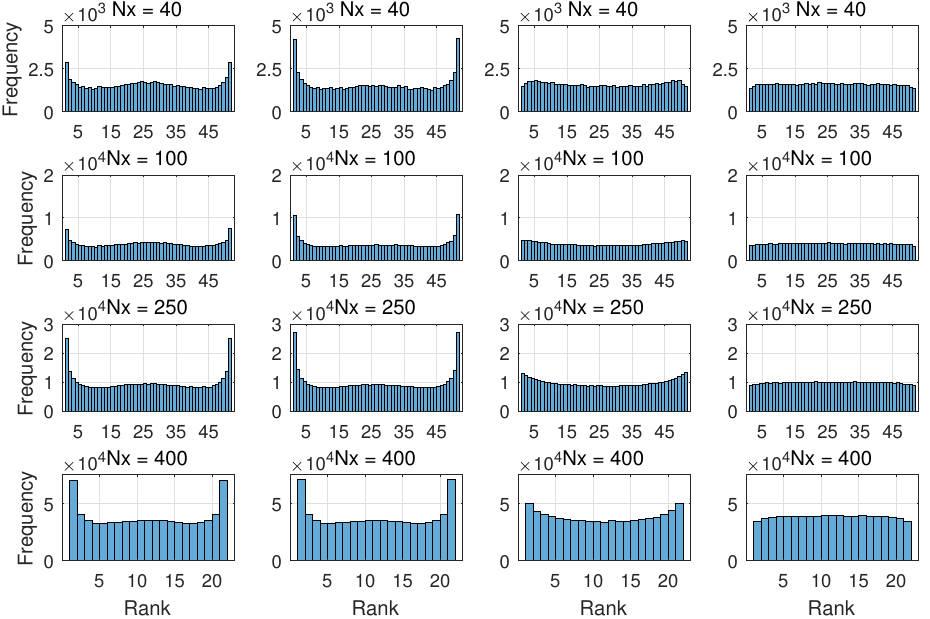
Figure 6. The rank histograms calculated from posterior particles generated by the IEWVPS (first column), En4DVar (second column), IEWPF (third column), and LETKF (last column). Ranks are aggregated over all steady-state time steps and all state